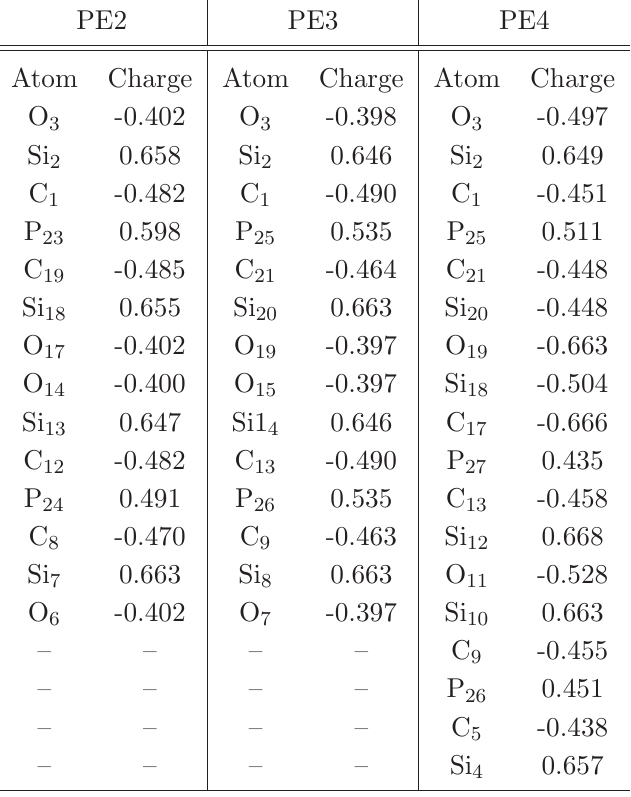
Table 8 Charge distribution in phosphinine-ether macrocycles from PM3 calculation